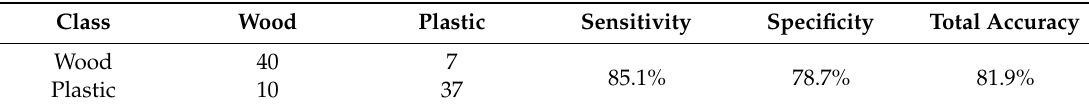
Table 8. DSVM classification performance for classifying wood vs. plastic using SKF cross-validation.